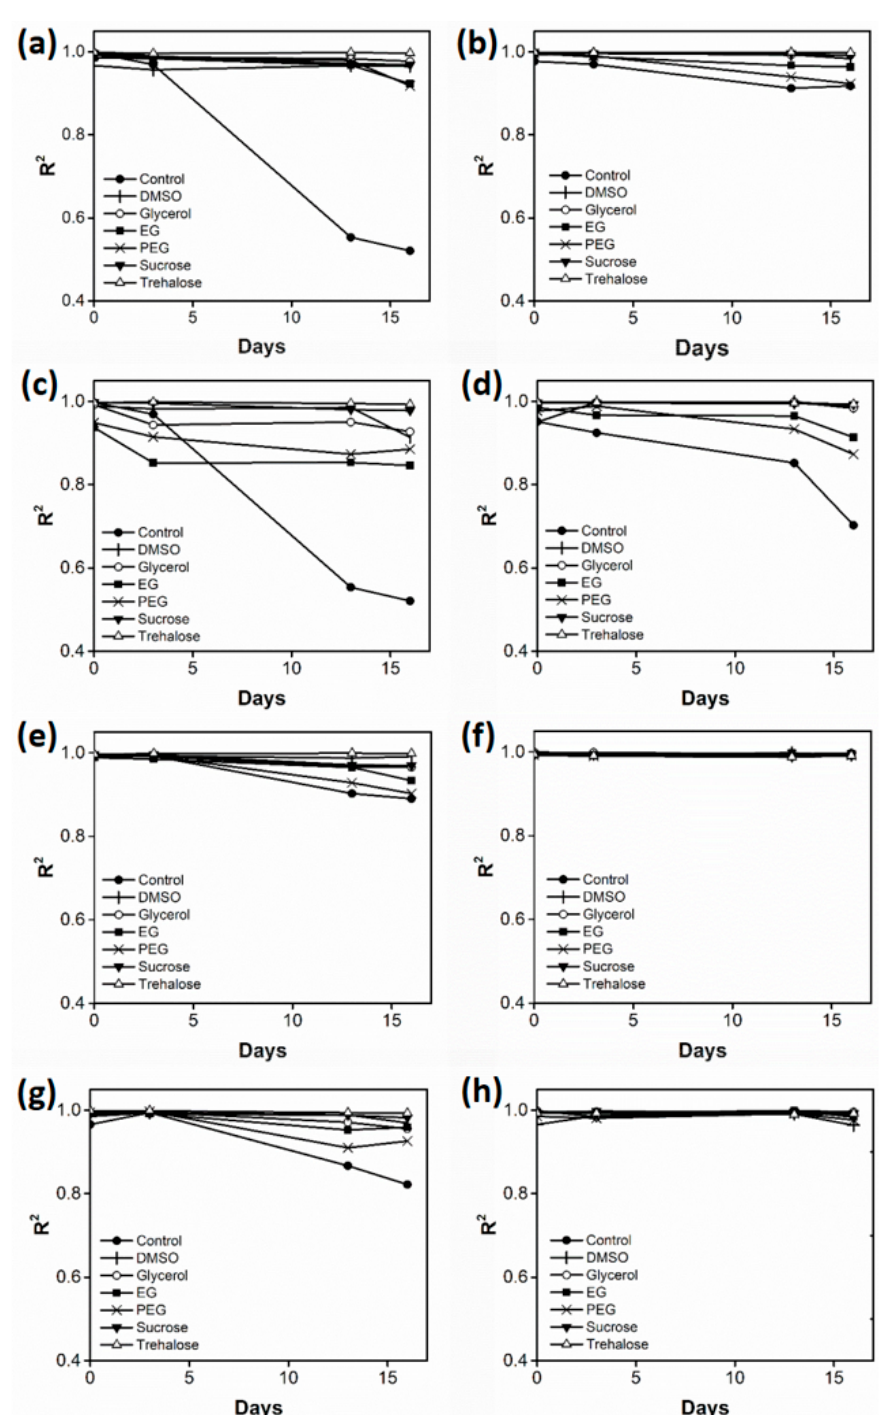
Figure 2. Coefficient of determination (R 2 ) values of the Met calibration curves generated using the amino acid array during the 16-day storage period under the following conditions: ( a ) 5% cryopro- tectant with agarose immobilization at − 20 °C, ( b ) 5% cryoprotectant with agarose immobilization at − 80 °C, ( c ) 10% cryoprotectant with agarose immobilization at − 20 °C, ( d ) 10% cryoprotectant with agarose immobilization at − 80 °C, ( e ) 5% cryoprotectant without agarose immobilization at − 20 °C, ( f ) 5% cryoprotectant without agarose immobilization at − 80 °C, ( g ) 10% cryoprotectant without agarose immobilization at − 20 °C, and ( h ) 10% cryoprotectant without agarose immobilization at − 80 °C.